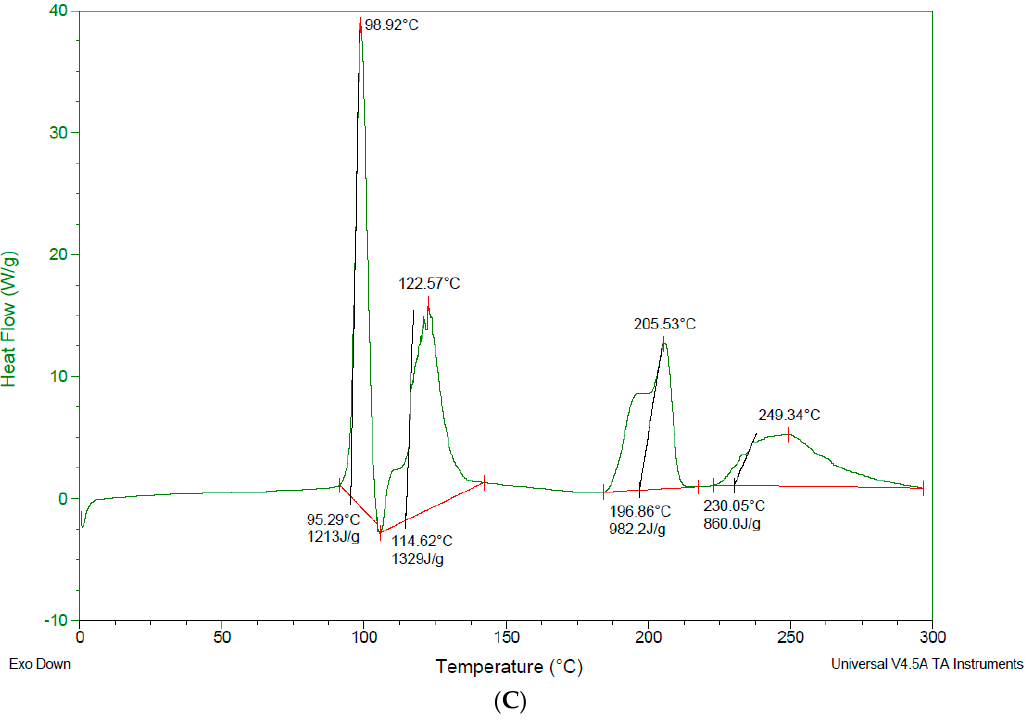
Figure 9. DSC data for pure excipients. ( A ) DSC for pure gluconolactone; ( B ) DSC for hydroxyl propyl γ -cyclodextrin; ( C ) DSC for trehalose.